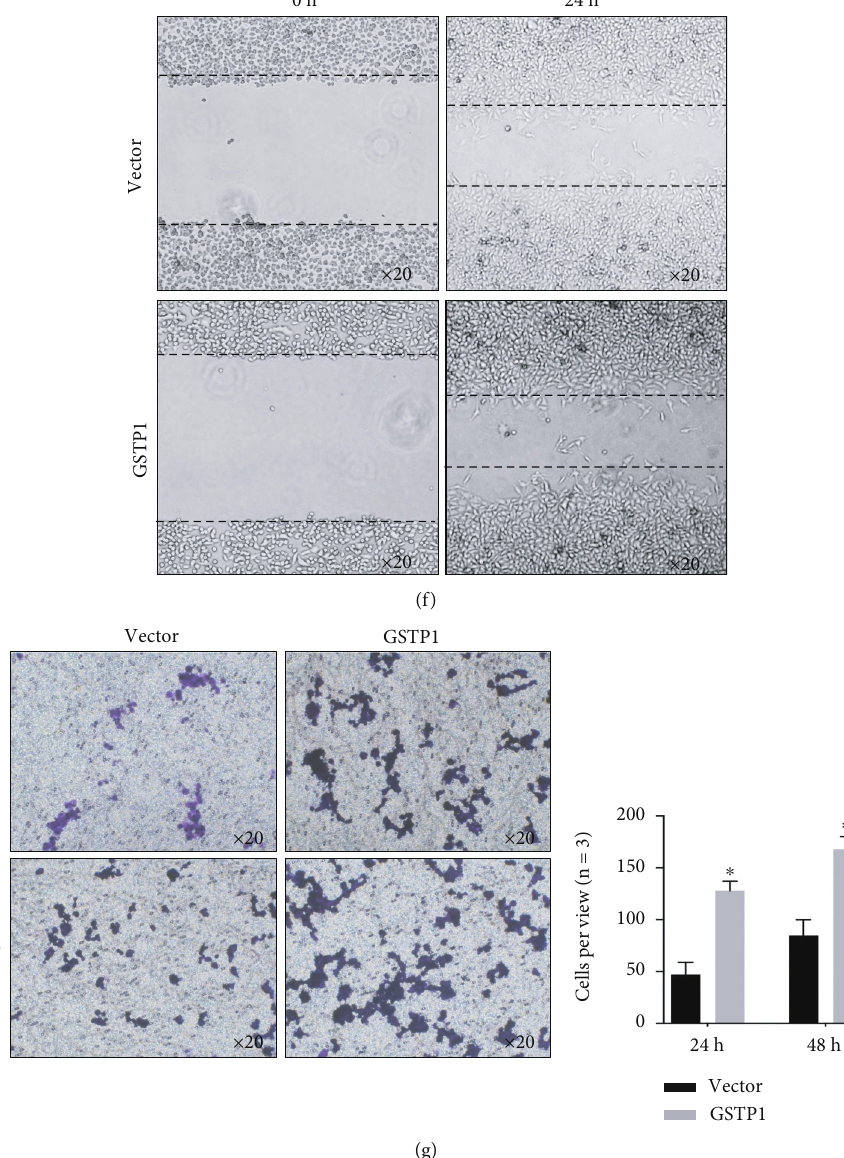
Figure 2: Overexpression of GSTP1 promotes cell proliferation. (a) After GSTP1 overexpression by lentivirus infection, e ffi cient overexpression of GSTP1 was detected by performing western blot. (b) After stable GSTP1 overexpression, cell viability was measured from day 1 to 5 by performing CCK-8 assay, respectively. * P < 0 : 05 , vs. vector group. (c) After being cultured for 24 hours on 6-well plate, cells were collected and fi xed by using 70% ethanol for 24 hours, and cell cycle distribution was measured by performing PI staining followed by fl ow cytometry analysis. * P < 0 : 05 , vs. vector group. After GSTP1 overexpression stably, colony formation (d), tumor formation in soft agar (e), migration (f), and invasion (g) were analyzed. * P < 0 : 05 , vs. vector